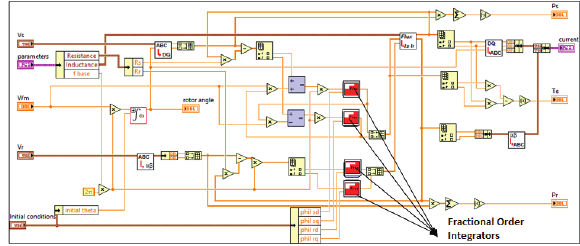
Fig. 10: Fractional order PMSG Model